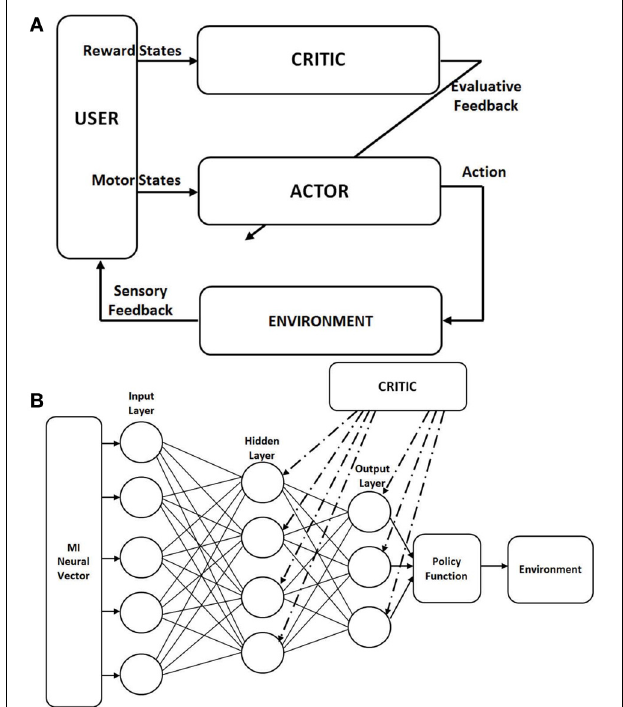
FIGURE 1 | Architecture of the actor-critic reinforcement learning (RL). (A) Classical actor-critic RL architecture as adapted for Brain-Machine Interface (BMI). The actor maps the neural commands into actions to control the external device. The actor is driven by the motor neural commands. The critic gives an evaluative feedback about the action taken based on its reward. This evaluative feedback is used to update the weights of the actor. The critic is driven by the neural data from the striatum for an autonomous BMI. (B) Actor network structure in the actor-critic RL; fully connected feed forward neural network with binary nodes, with 5 nodes in the hidden layer. The policy function used is the “greedy” policy which selects the node with the highest value at the output layer and channels that action to the environment. The critic gives an evaluative feedback to all nodes in the output and hidden layers. This modulates the synaptic weight updates based on the local pre- and postsynaptic